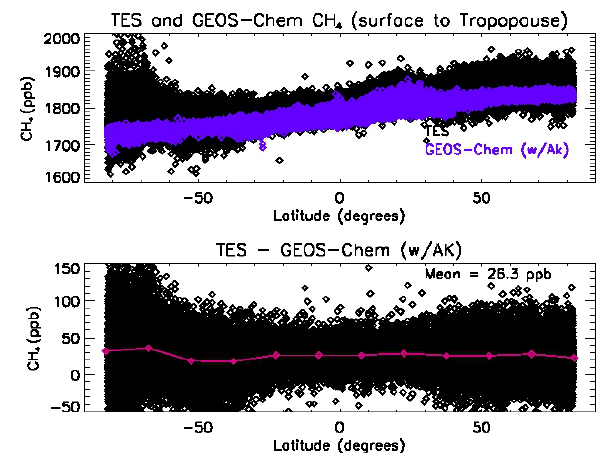
Fig. 4. (Top panel) Latitudinal distribution of TES October 2006 tropospheric CH 4 estimates (black diamonds) correspond- ing GEOS-Chem estimates adjusted with TES instrument operator (blue diamonds). (Bottom panel) Difference between TES and ad- justed GEOS-Chem estimates (black – blue from top panel). The red line in the bottom panel shows the mean difference between TES and the adjusted GEOS-Chem estimates when these differences are averaged for data within 15-degree latitude